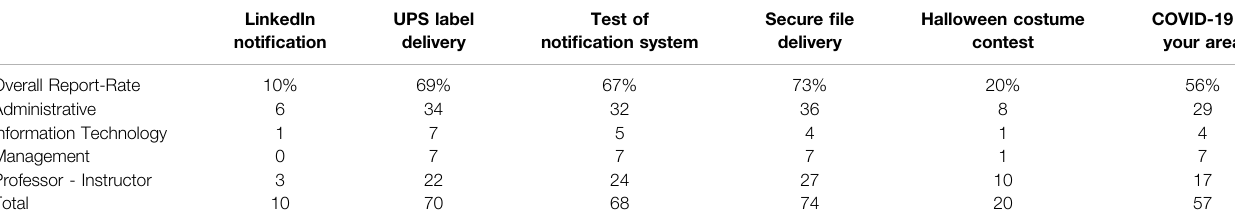
TABLE 5 | Report-rates by email template and job